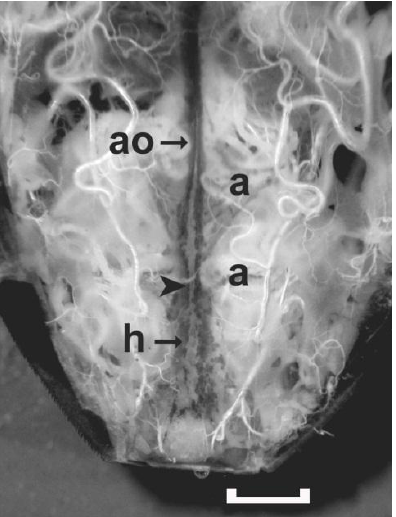
Figure 4. A live preparation covered with Rhodnius saline showing the posterior region of the dorsal vessel of an adult female R. prolixus exposed by removing the dorsal